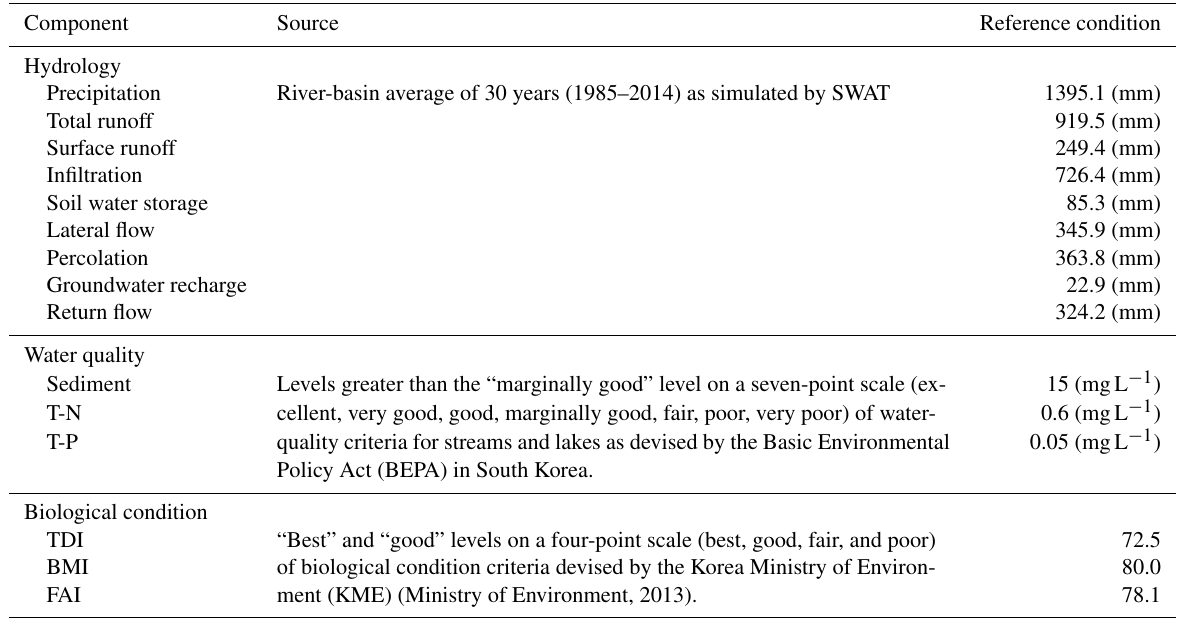
Figure 6. Water-quality condition for the (a) sediment, (b) T-N, and (c) T-P according to the hydrological (SWAT) modeling for the period from 1985 to 2014 in the Han River basin. Table 4. Summary of the hydrology, water-quality, and biological criteria that were used to screen for the reference condition in the Han River